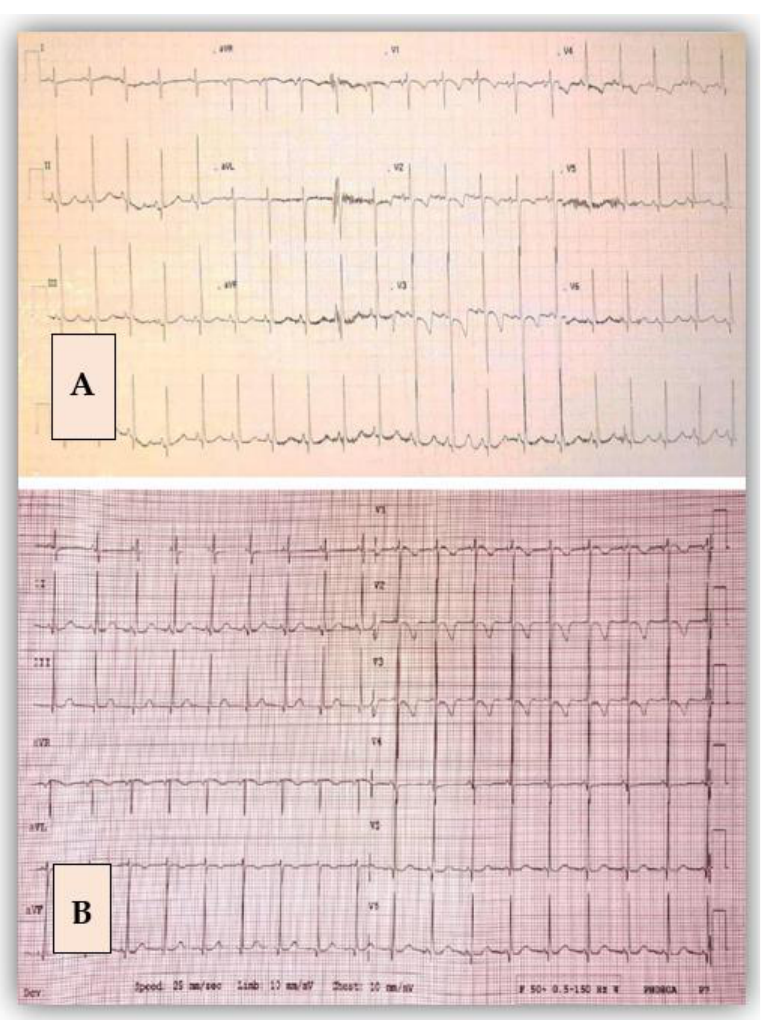
Figure 6. Electrocardiogram before ( A ) and after the surgical intervention ( B ). After the surgery, there was a flat T wave in V4 compared with the initial image.